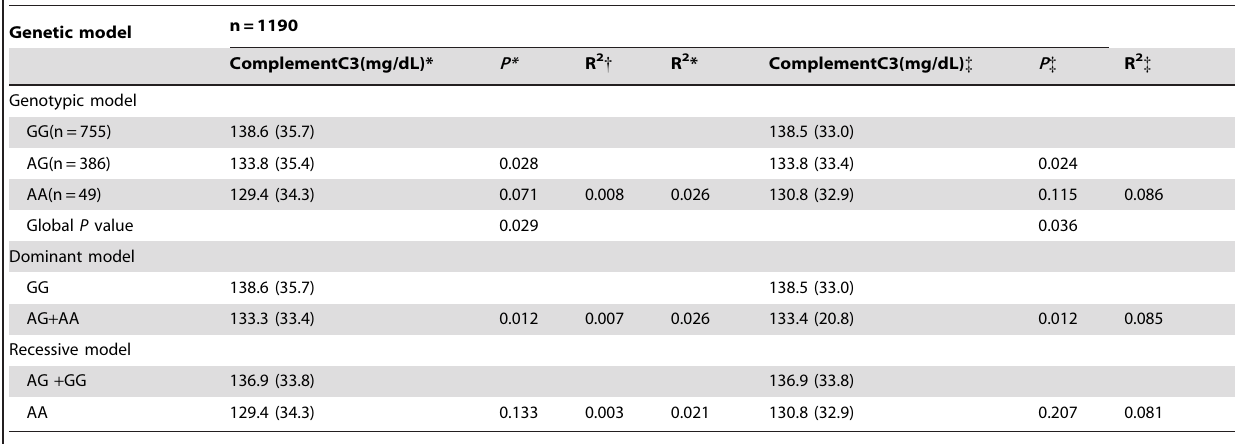
Table 4. Association of rs2230500 with complement C3.